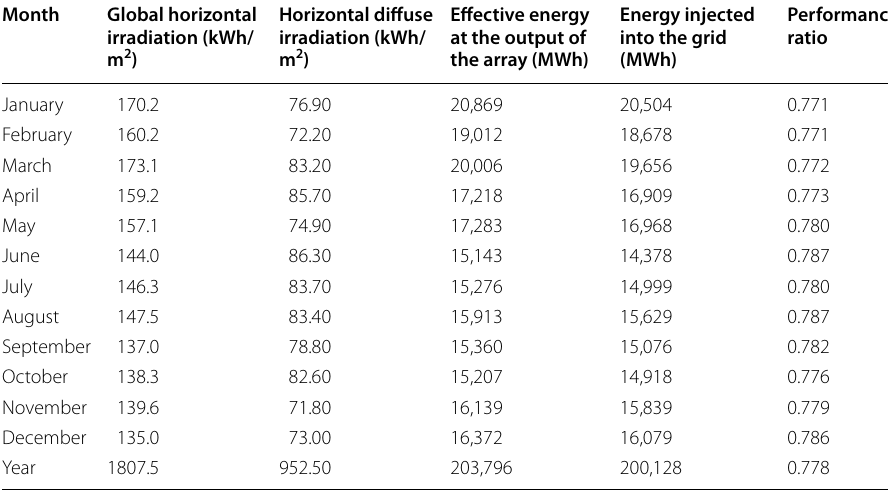
Table 8 Balances and main results of LSS farm design